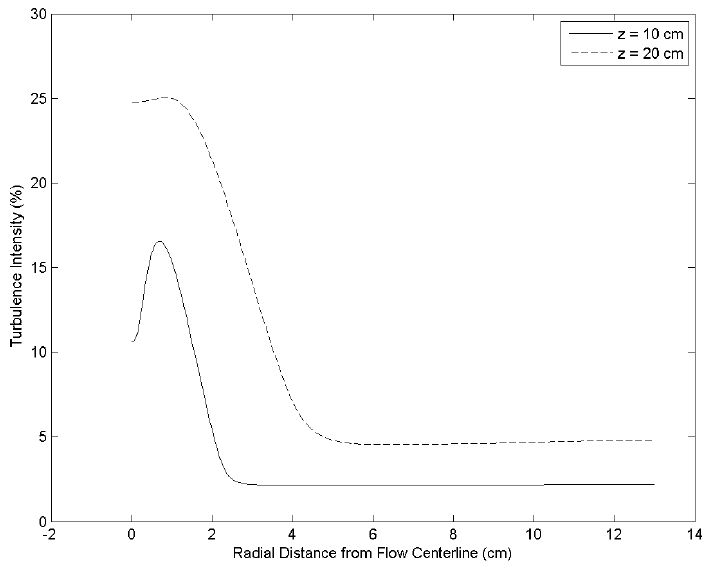
Figure 20. Experiment 1: The numerical turbulence intensity at 10 cm and 20 cm from the cap face found using the coarsest Grid 3 and the k -ε realizable turbulence model.